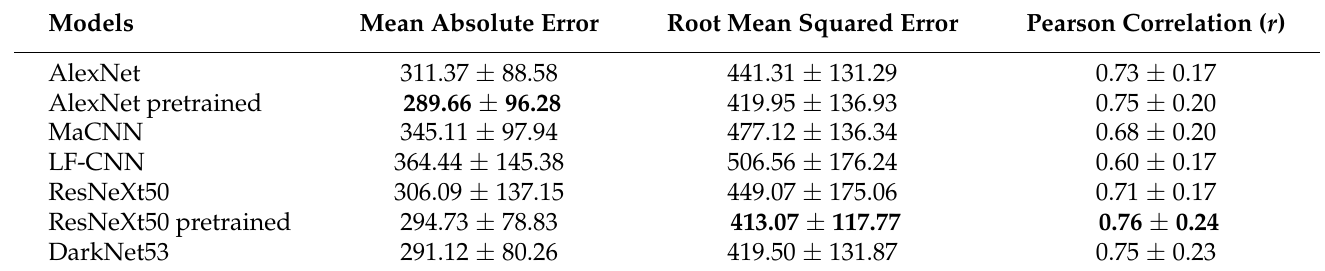
Table 4. Results for